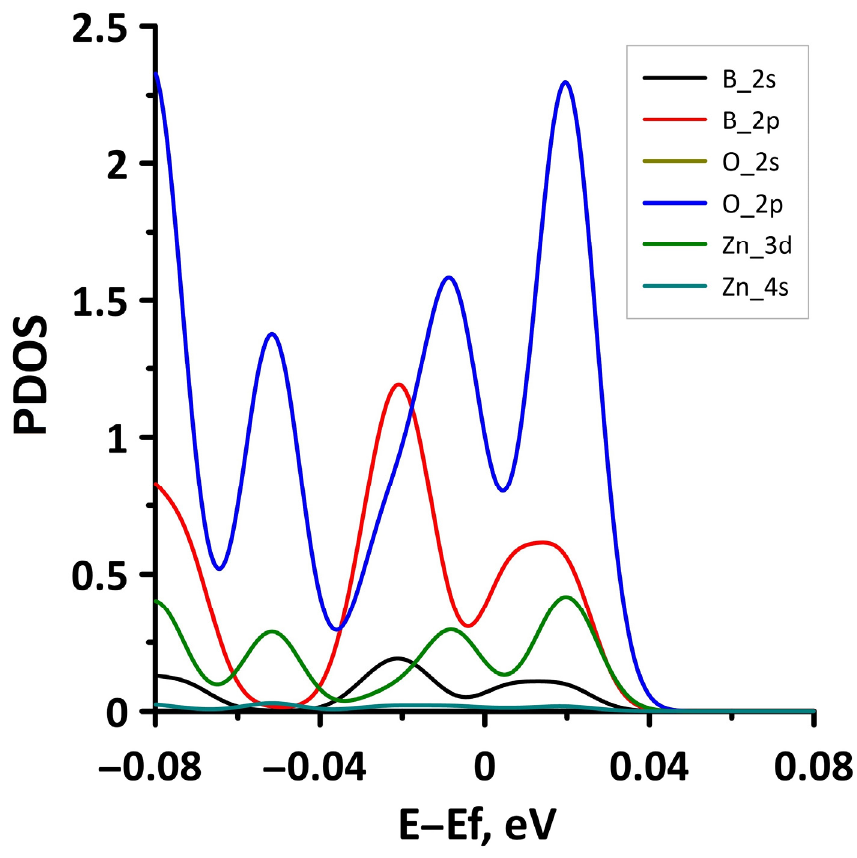
Figure 12. Fragments of PDOS near the Fermi level (shifted to 0 eV) of borophene/ZnO heterostruc- ture under uniaxial compression by 14%.